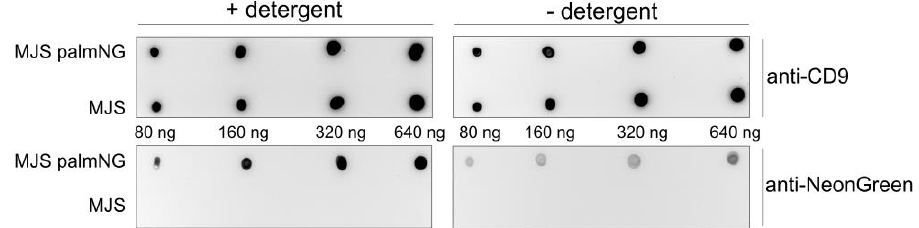
Figure 3. Localization of palmNG in EVs. Various amounts of EVs from MJS or MJSpalmNG cells were dot-blotted in a dose range on a nitrocellulose membrane and analyzed by immunoblotting with the use of anti-mNeonGreen or anti-CD9 antibody in the presence or absence of a detergent. 3.4. PalmNG EVs Internalized by Huh-7 Cells Localize Predominantly to the Perinuclear